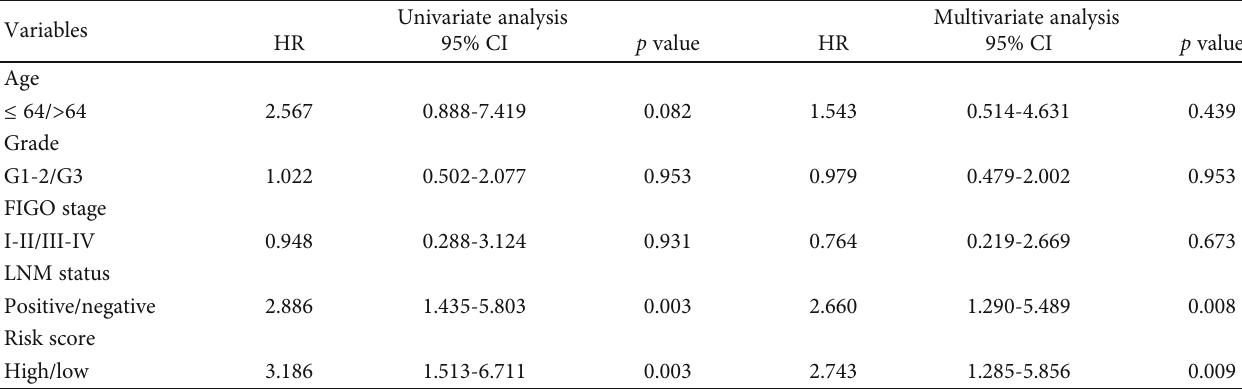
Table 2: Univariate/multivariate Cox regression